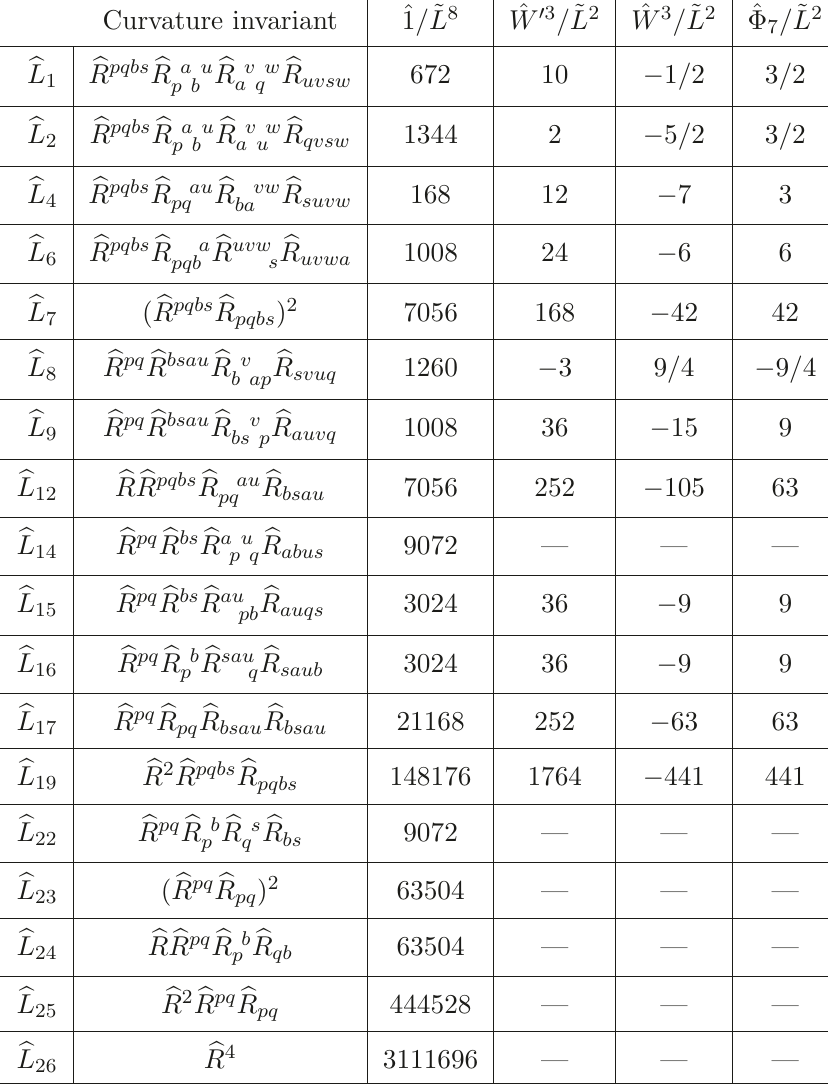
Table 6 . 7D basis of quartic curvature